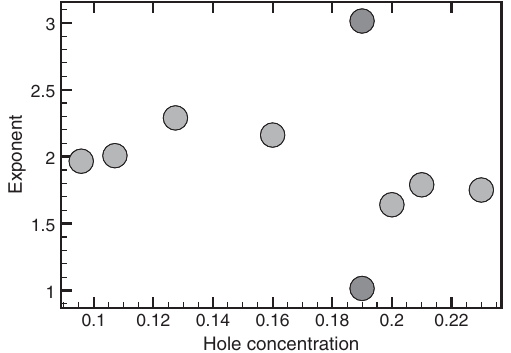
FIG. 7. Exponents of the equation E iso FIG. 6. Phase diagram summarizing the temperature character- from fitting the normal state temperature dependence of the izing the step in γ iso ð T Þ : The temperature of the extremum, intraisosbestic integrated loss-function intensity, shown in C =T coinciding with the superconducting phase transition ( T ), Figs. 8 – 15. The two values indicated for the 19% doped sample n 1 p 1 =T and the upper limit of the step ( T ). (dark gray) refer to different temperature n 2 p 2